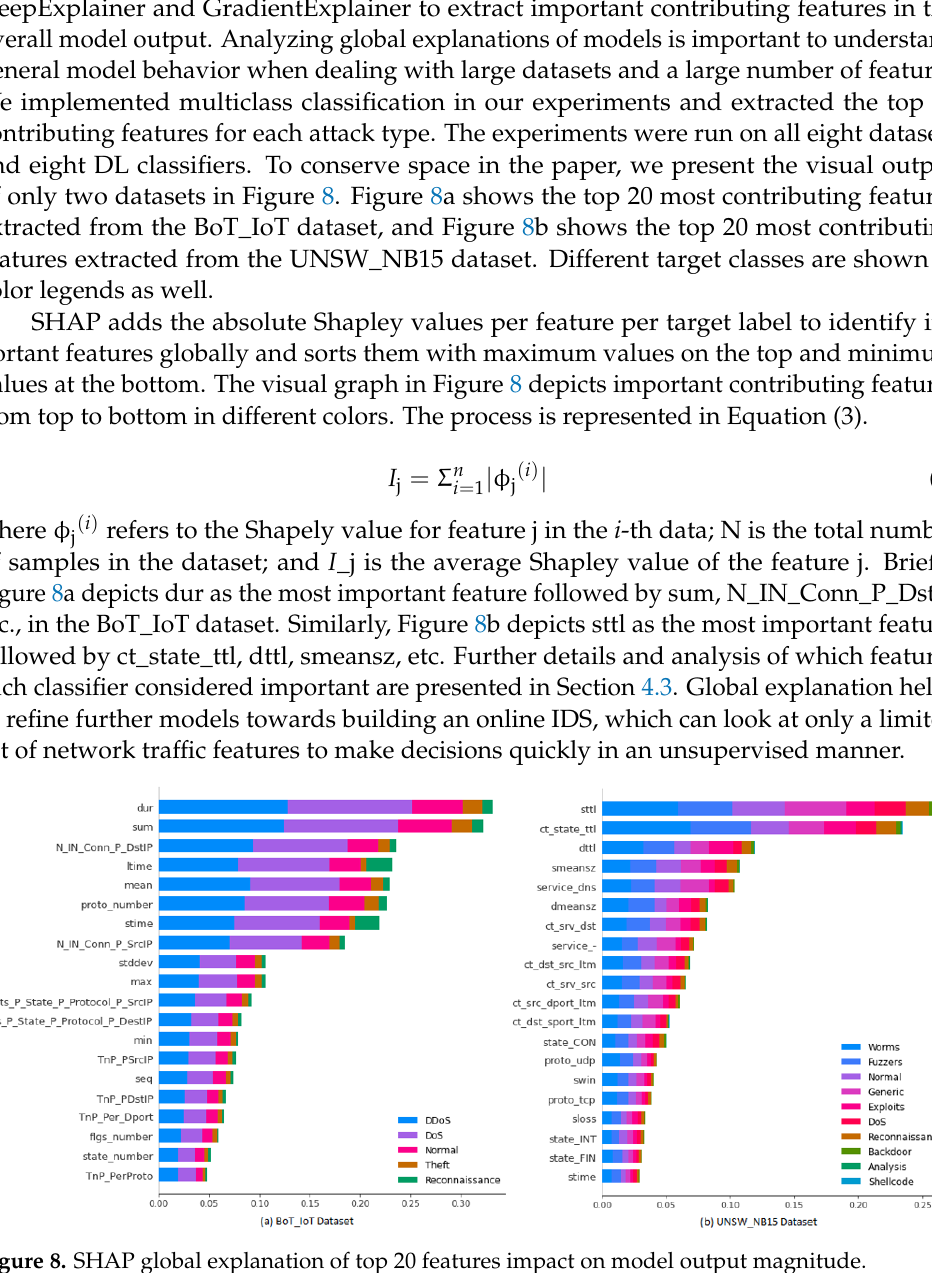
Figure 8. SHAP global explanation of top 20 features impact on model output